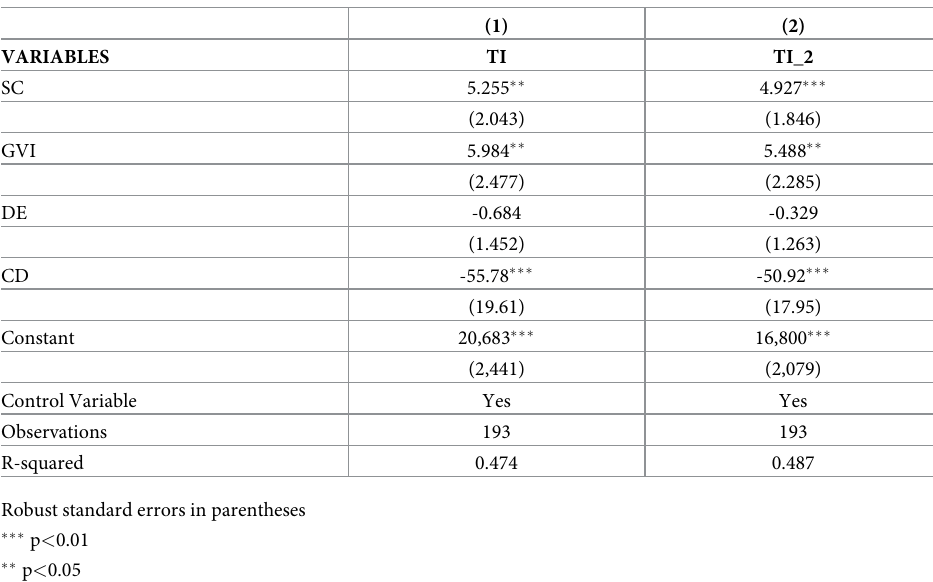
Table 4. Robustness test (delete special city